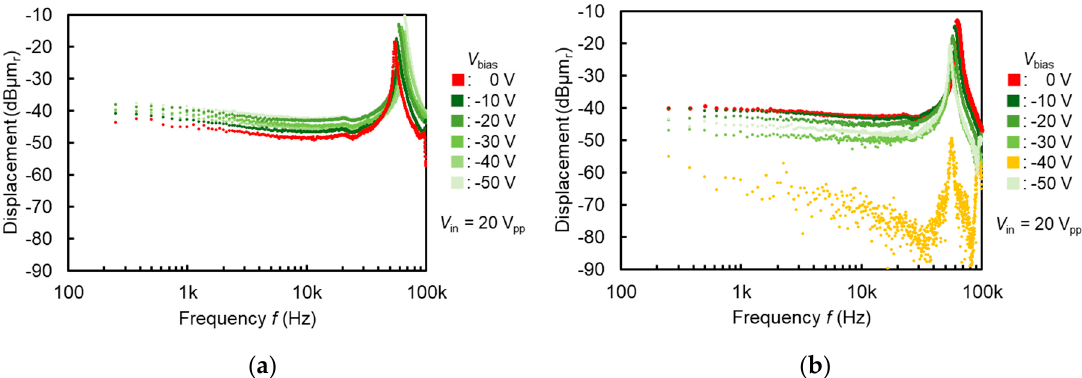
Figure 11. Frequency characteristics of out-of-plane φ = 1.5 mm membrane actuator: ( a ) before electret fabrication; ( b ) after − 40 V electret fabrication. Unit of vertical axis is standardized displacement ( µ m r ) dB µ m r = 20log X 1 ( µ m r )